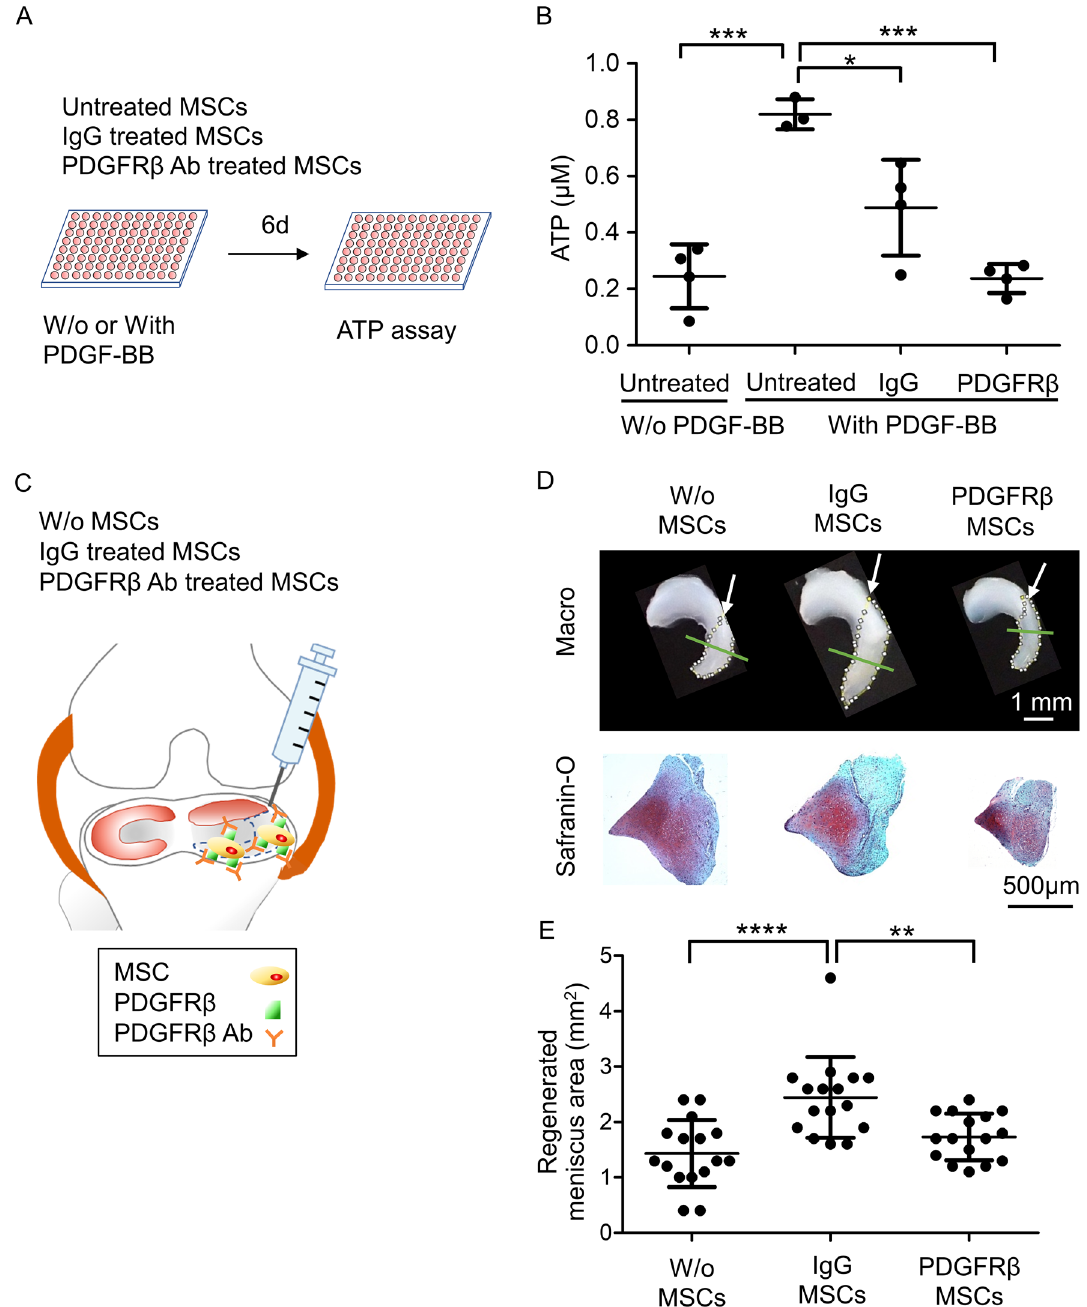
Figure 2. Effect of PDGFRβ neutralizing antibody treatment of rat synovial MSCs on proliferation and meniscus regeneration. ( A ) Scheme of the in vitro proliferation experiment. Untreated, IgG-treated, and PDGFRβ neutralizing antibody–treated MSCs were cultured in well plates with 4 ng/mL PDGF-BB for 6 days. ( B ) Quantification of ATP per well as an indicator of cell number. Original stock MSCs were used and four wells were tested for one condition. The average values and SD are shown ( n = 4). *, p < 0.05; ***, p < 0.001 between each treatment. ( C ) Scheme of the in vivo meniscus regeneration experiment. After partial meniscectomy, rat knees were transplanted with vehicle alone (W/o MSCs), IgG-treated MSCs, or PDGFRβ neutralizing antibody– treated MSCs. Three weeks later, the meniscus was removed and observed macroscopically and microscopically. ( D ) Representative macroscopic images of the meniscus and histological images of the regenerated meniscus by safranin-O staining. The regenerated areas are indicated by the yellow dotted line. Arrow indicates the meniscus resected site. Green line indicates the specimen cross section location. ( E ) Quantification of regenerated area. Original stock MSCs were used and 16 knees of 8 rats were tested for one condition. The average values and SD are shown ( n = 16). **, p < 0.01; ****, p < 0.0001 between each